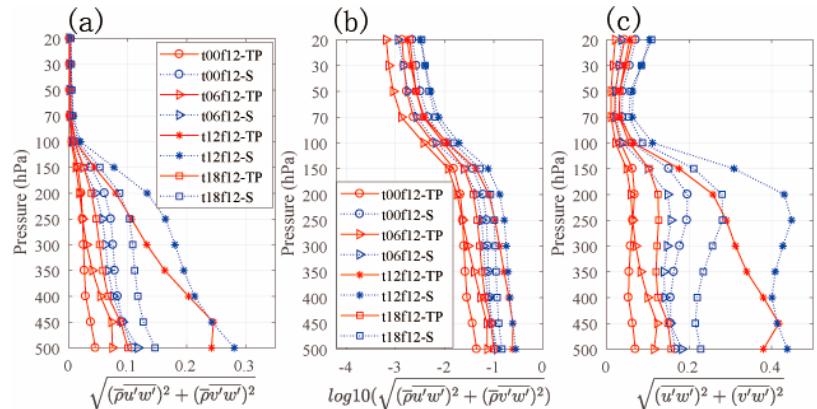
Figure 5. Diurnal variation of ( a ) area-averaged momentum fluxes per unit volume (unit: Pa), ( b ) common logarithm (base 10) of area-averaged momentum fluxes per unit volume (unit: Pa) and ( c ) area-averaged momentum fluxes per unit mass (unit: J / kg) varying with height at 00 UTC (circle), 06 UTC (triangle), 12 UTC (star) and 18 UTC (square) above the main TP (red solid line) and south slope of TP (blue dotted lines). Legends are abbreviations of simulation information. For example, f06 (12) refers to 6(12)-h forecast. t00 (06,12,18) refers to UTC time. TP refers to the main TP region and S refers to the south slope of the TP.